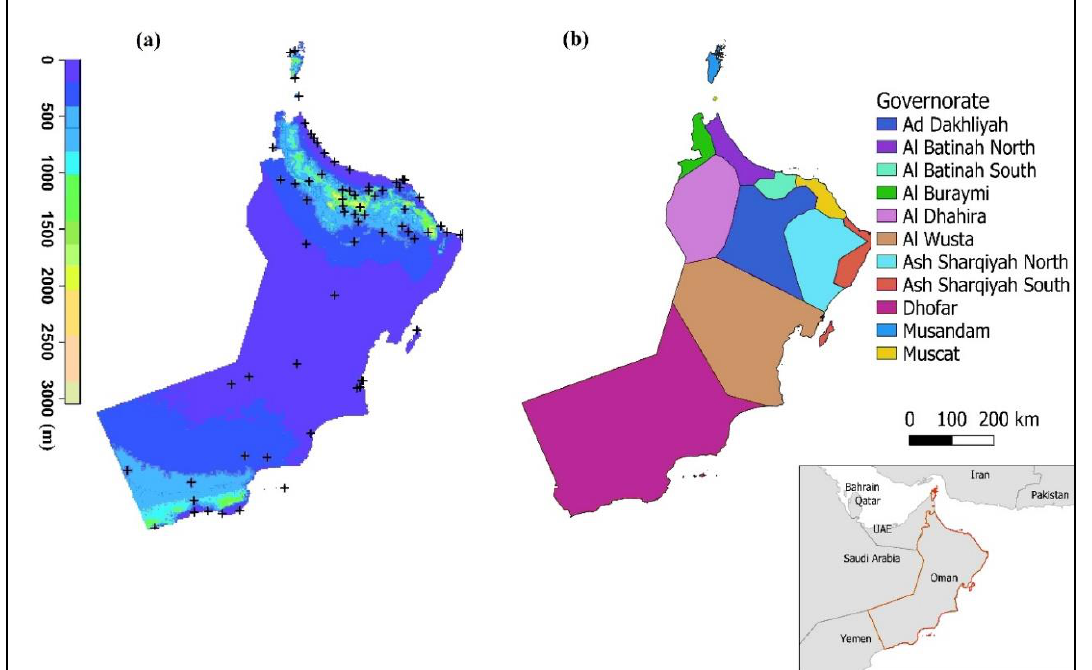
Figure 1. Map of the Sultanate of Oman showing the rain-gauge stations, ( a ) elevation and ( b ) 11 governorates. The points with cross signs indicate rain-gauge locations.